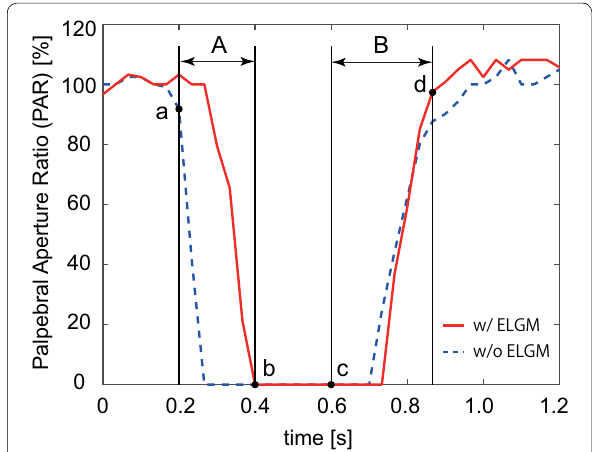
Fig. 11 Changes in the palpebral aperture ratio (PAR) over time. The red line shows the PAR change with support, and the blue broken line shows the PAR change without support. Dots correspond to the states in Fig. 10. Moreover, the average values of “A” and “B” was calculated, and these values are shown in Fig. 12